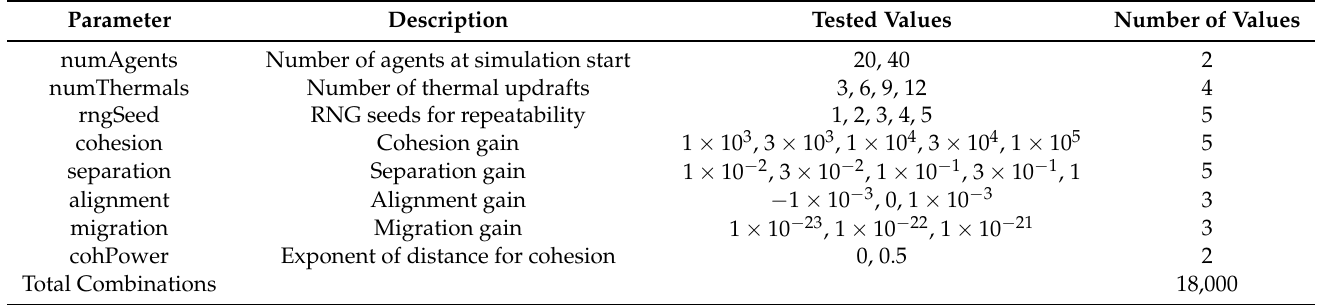
Table 1. Overview of parameters varied in latest simulation batch, including a description, the values tested, the number of values of each parameter, and the number of resulting combinations of all